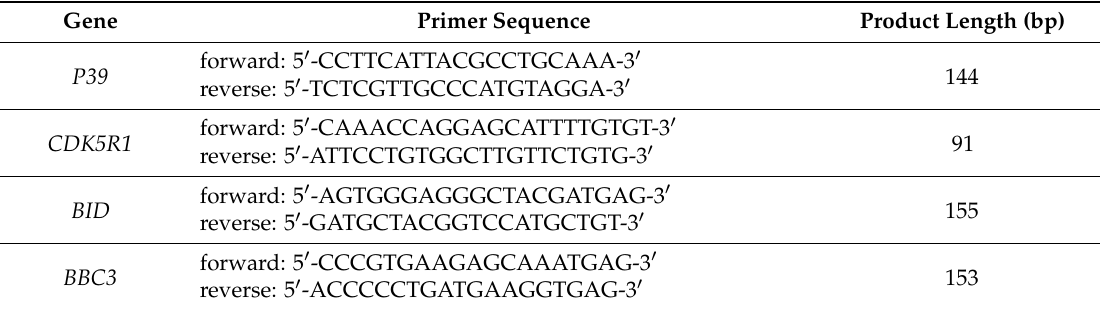
Table 1. Primer sequences for real-time